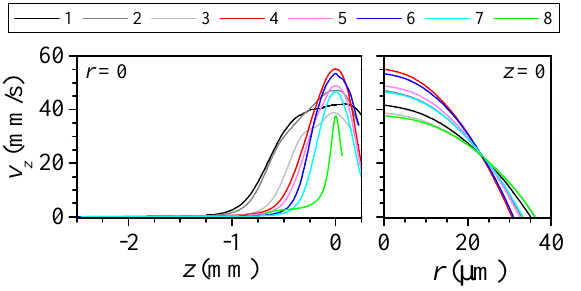
Figure 4. Axial velocity at the axis along the nozzle ( left ), and at the nozzle neck ( right ) for all the nozzles. The line colour indicates the nozzle number in Table